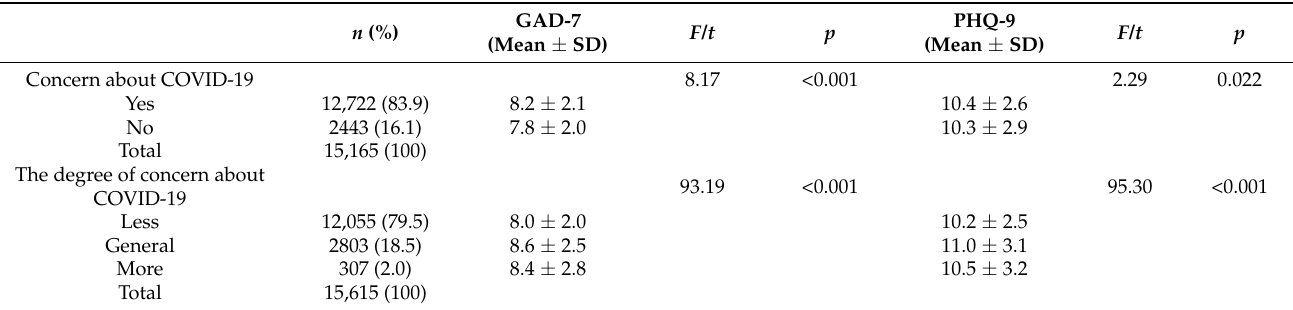
Table 3. Patient’s concern about the COVID-19